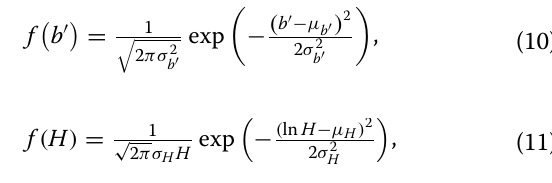
100 in area A; c N =